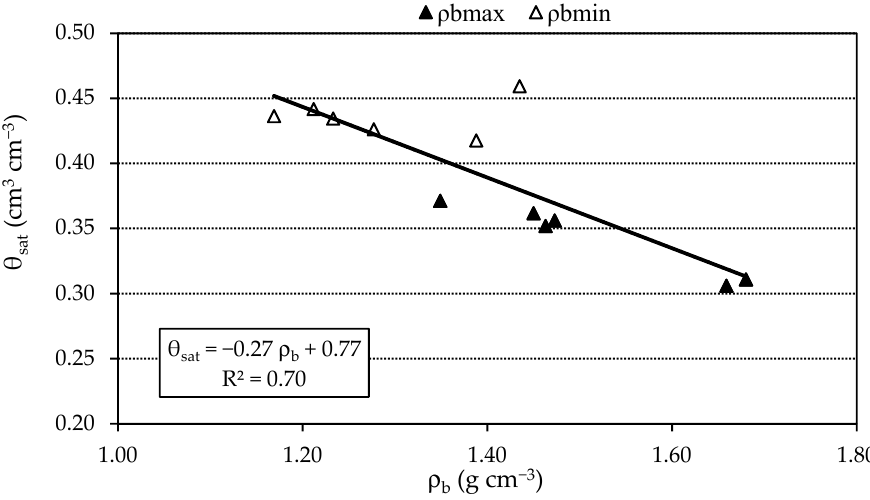
Figure 4. Relationship between saturated volumetric water content, θ sat , and the corresponding bulk density, ρ b , for all the repacked monoliths.